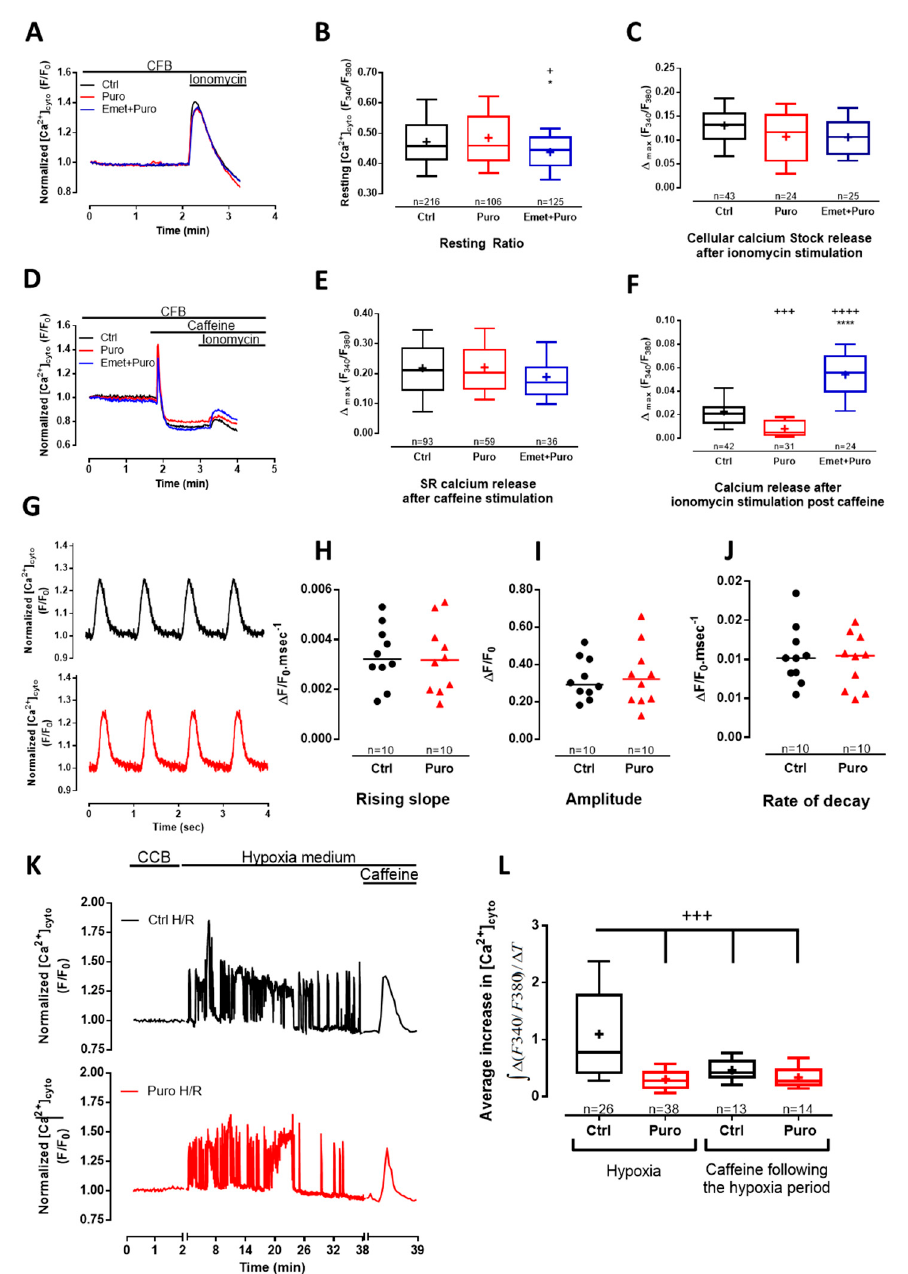
Figure 2. The reticular puromycin-mediated Ca 2+ stock release was independent of the one stimulated by caffeine and did not affect excitation–contraction (E-C) coupling. ( A , D ) Time traces showing cytosolic Ca 2+ concentration assessed by fura2-AM (acetoxymethyl ester) cytosolic probe, in Ctrl condition and after 30 min of 200 μ M puromycin pretreatment or 20 μ M emetine +200 μ M puromycin pretreatment. Effect of puromycin and emetine + puromycin was measured after cardiomyocyte (CM) pretreatment in Ca 2+ -containing buffer (CCB) for 30 min (see the Materials and Methods section). Ca 2+ content was figured out by the maximum amplitude of fura2-AM fluorescence ratio ( ∆ max Ratio (340/380) ) after the addition of different stimulations in a Ca 2+ -free buffer (CFB). ( B ) Box blots representing the steady-state cytosolic Ca 2+ concentration and ( C ) total cell Ca 2+ content assessed by 5 μ M of ionomycin stimulation. ( E ) RyR 2 -dependent Ca 2+ stores assessed by 10 mM of caffeine stimulation and ( F ) remaining cell Ca 2+ content after caffeine stimulation assessed by ionomycin stimulation. ( G – J ) Cytoplasmic Ca 2+ transients were recorded using fluo5-AM–loaded intact CM electrically stimulated at 1 Hz. ( G ) Representative cytoplasmic Ca 2+ transients in the absence or after 30 min of puromycin pretreatment; Δ F/F0 = normalized change fluorescence. ( H ) Scatter blots